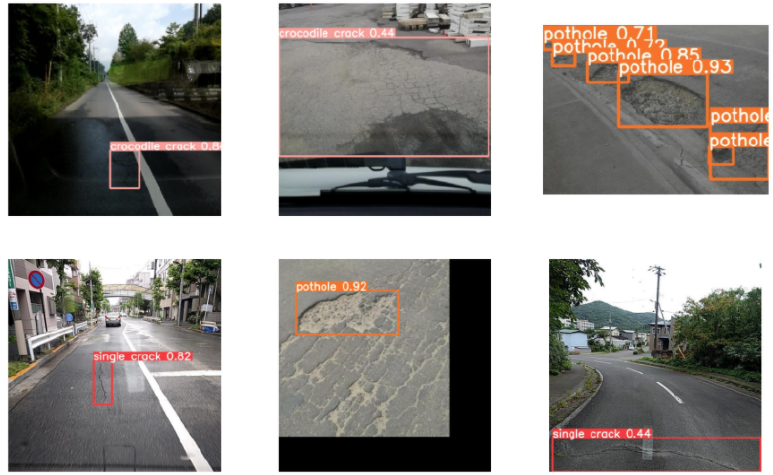
Figure 9. Examples of detection results with the best-performing model: YOLOv5l. It is good to note that the sample at the centre of the bottom row fails to contain an additional bounding box for the visible crocodile